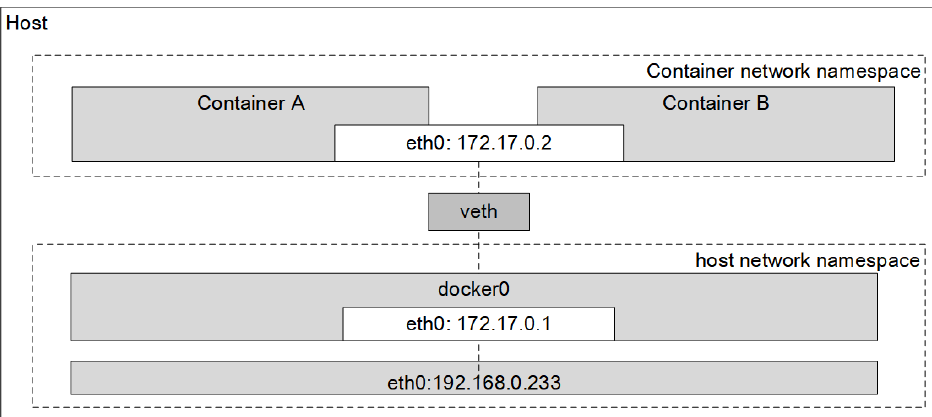
Figure 7. ‘Container Mode’ communication method in a single host.